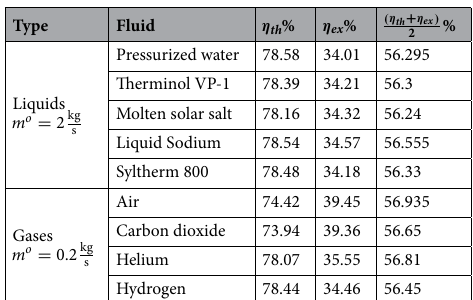
Table 6. Comparison of the performance among the fluids at selected inlet temperature (500 K).